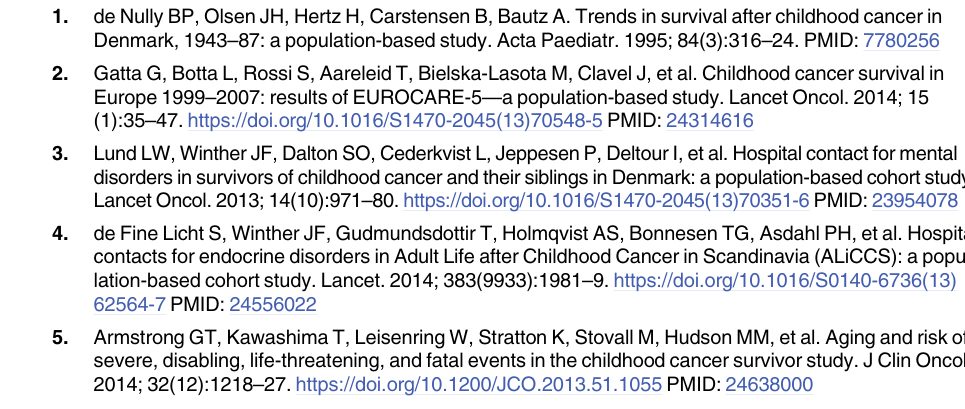
S3 Fig. Standardised bed day ratio (SBDR) with cancer recurrence or new primary cancers by childhood cancer